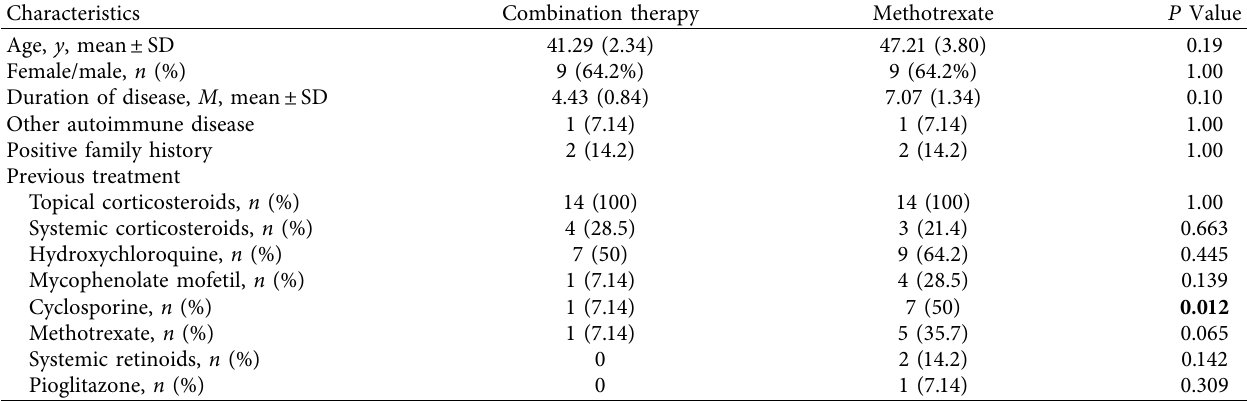
Table 1: Characteristics of participants by intervention groups at baseline